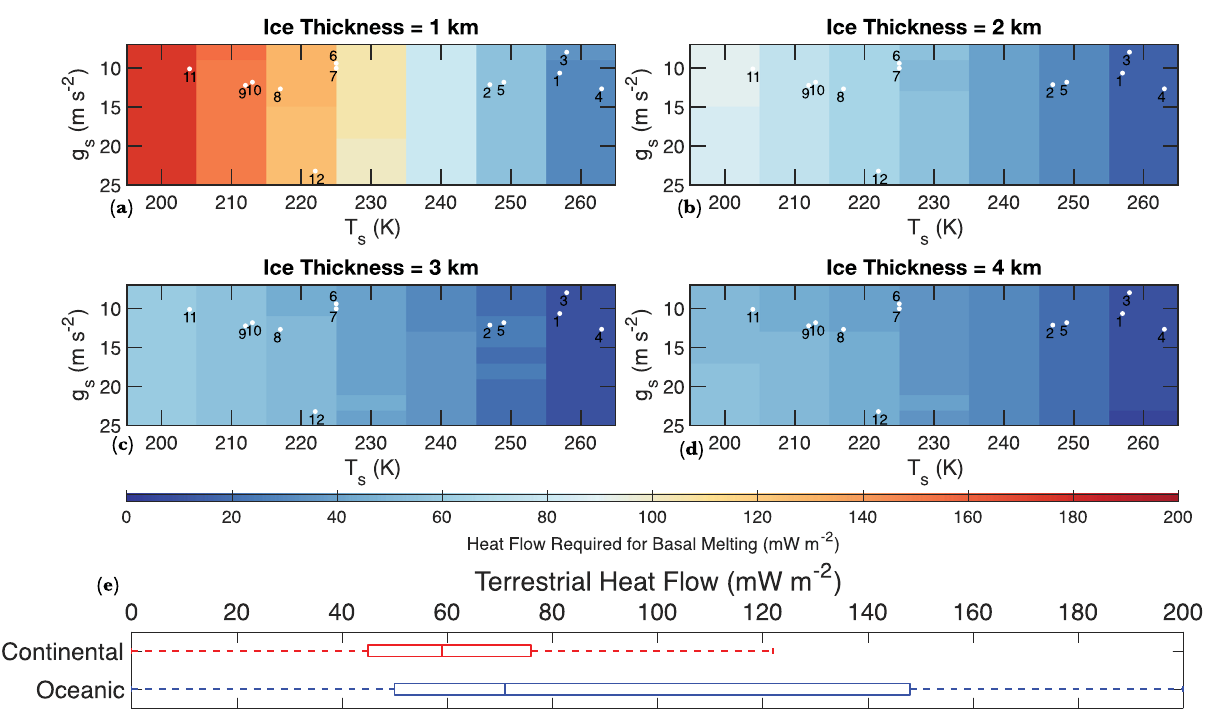
Fig.4|Heat fl owrequiredforbasalmeltingasafunctionofsurfacegravityand temperature for ice sheets 1 – 4km in thickness. a Heat fl ow required for basal meltingasafunctionofsurfacegravityandsurfacetemperaturefora1-kmthickice sheet. The white dots (the numbers correspond to the index number of planets in Table1)showthe approximatesurface gravityand surface temperatureof theexo-